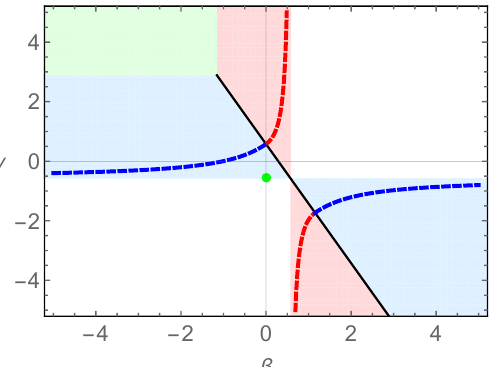
. The black line represent 3 ; 0 ; (cid:0) 1 p 3 3